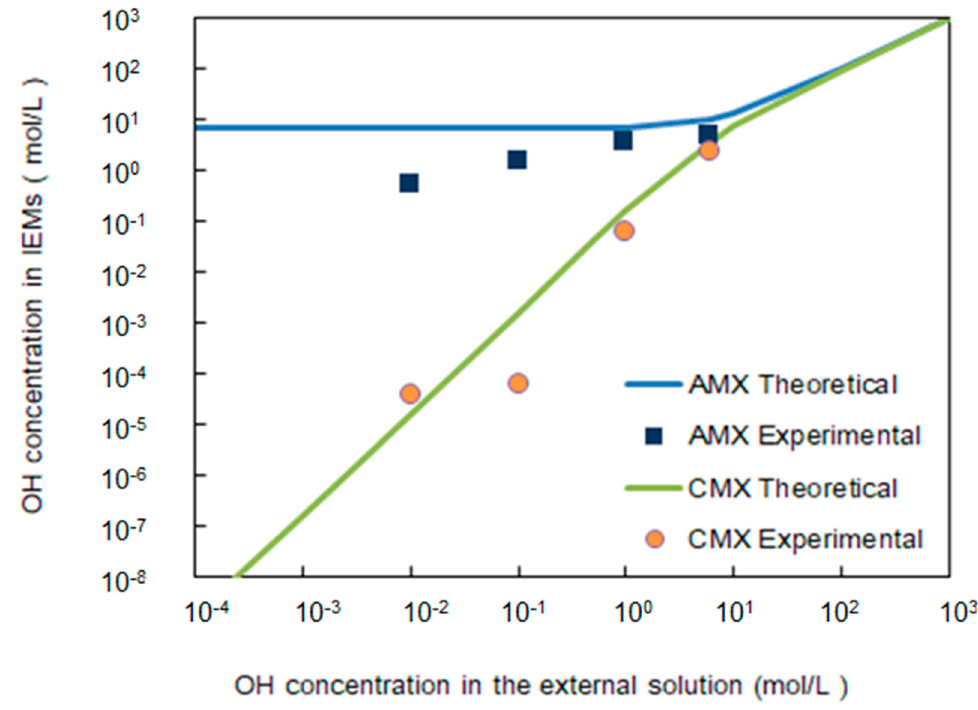
Figure 2. Theoretical and experimental values of hydroxyl ion concentration in the ion-exchange membranes (IEMs) as a function of the external solution concentration.